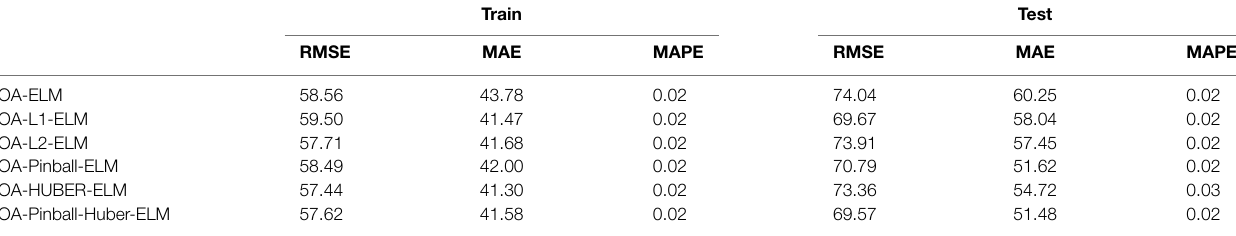
TABLE 3 | Evaluation index of Taixing data is obtained from three prediction algorithm experiments. Train Test RMSE MAE MAPE MAE